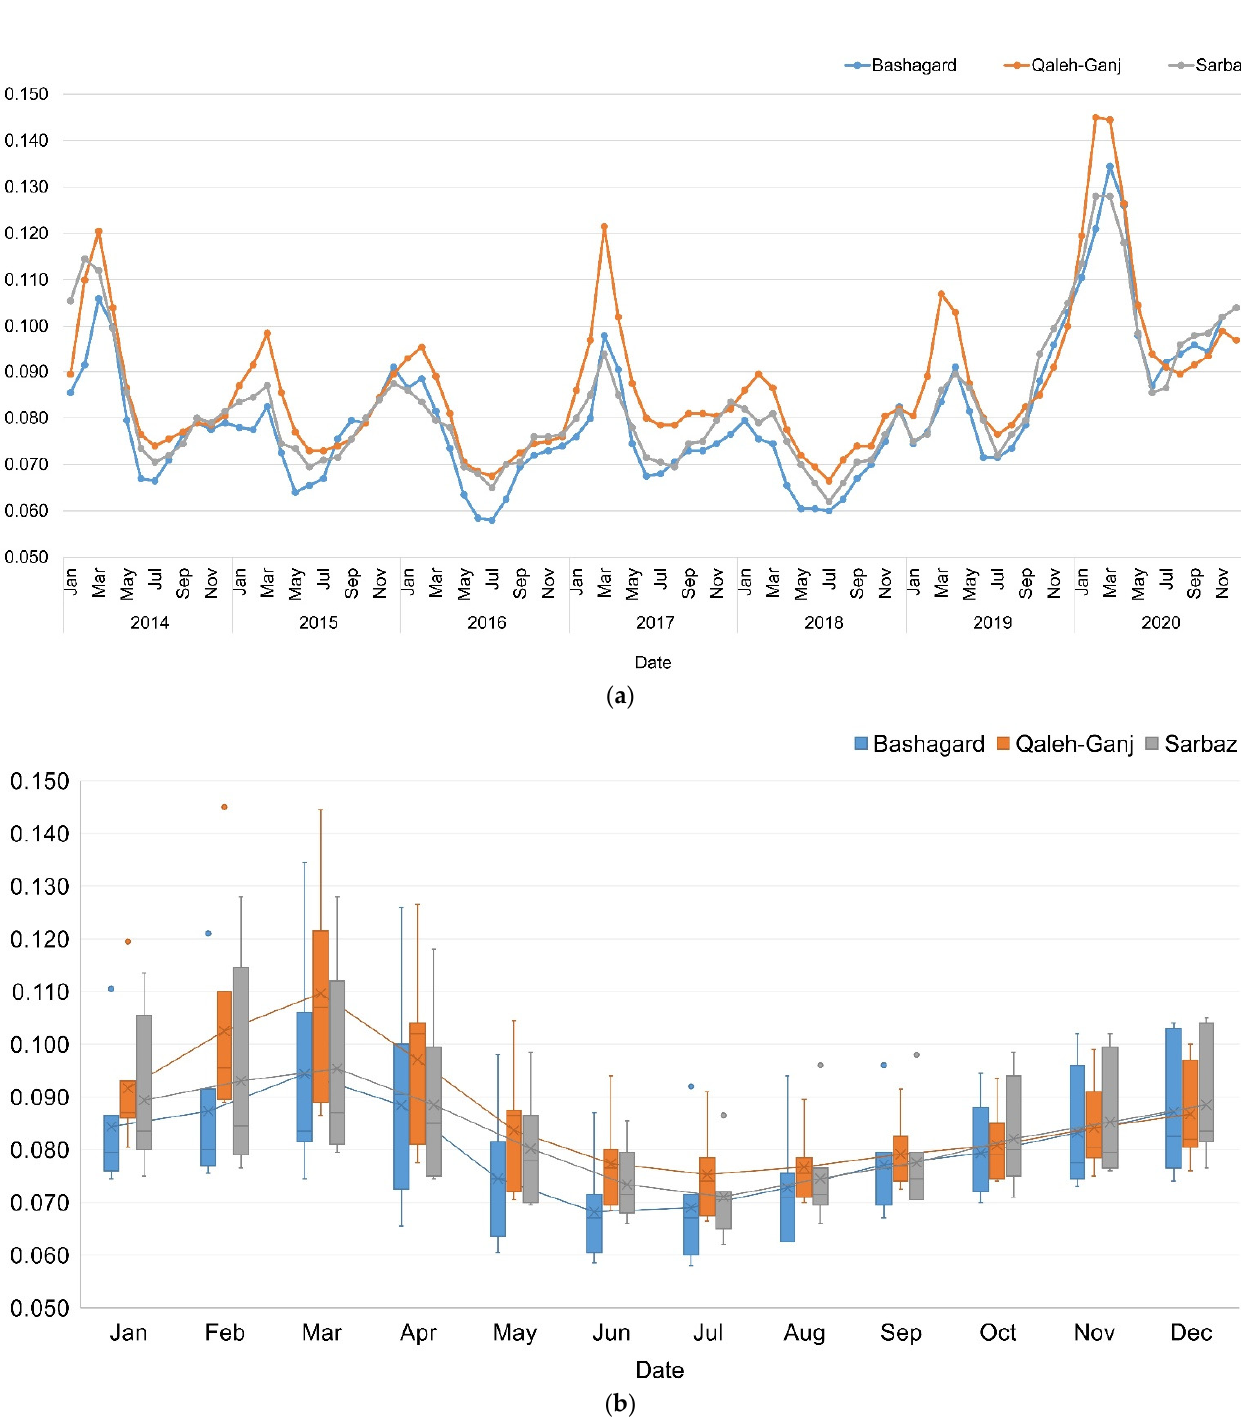
Figure 5. ( a ) NDVI time series; ( b ) Box plot of adaptive NDVI time series of Qaleh-Ganj, Sarbaz